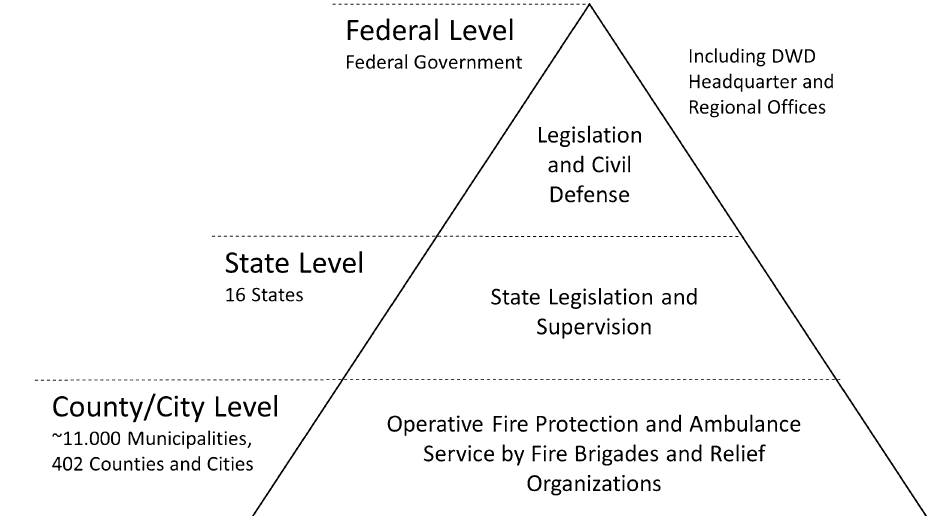
Fig. 2 Schematic illustration